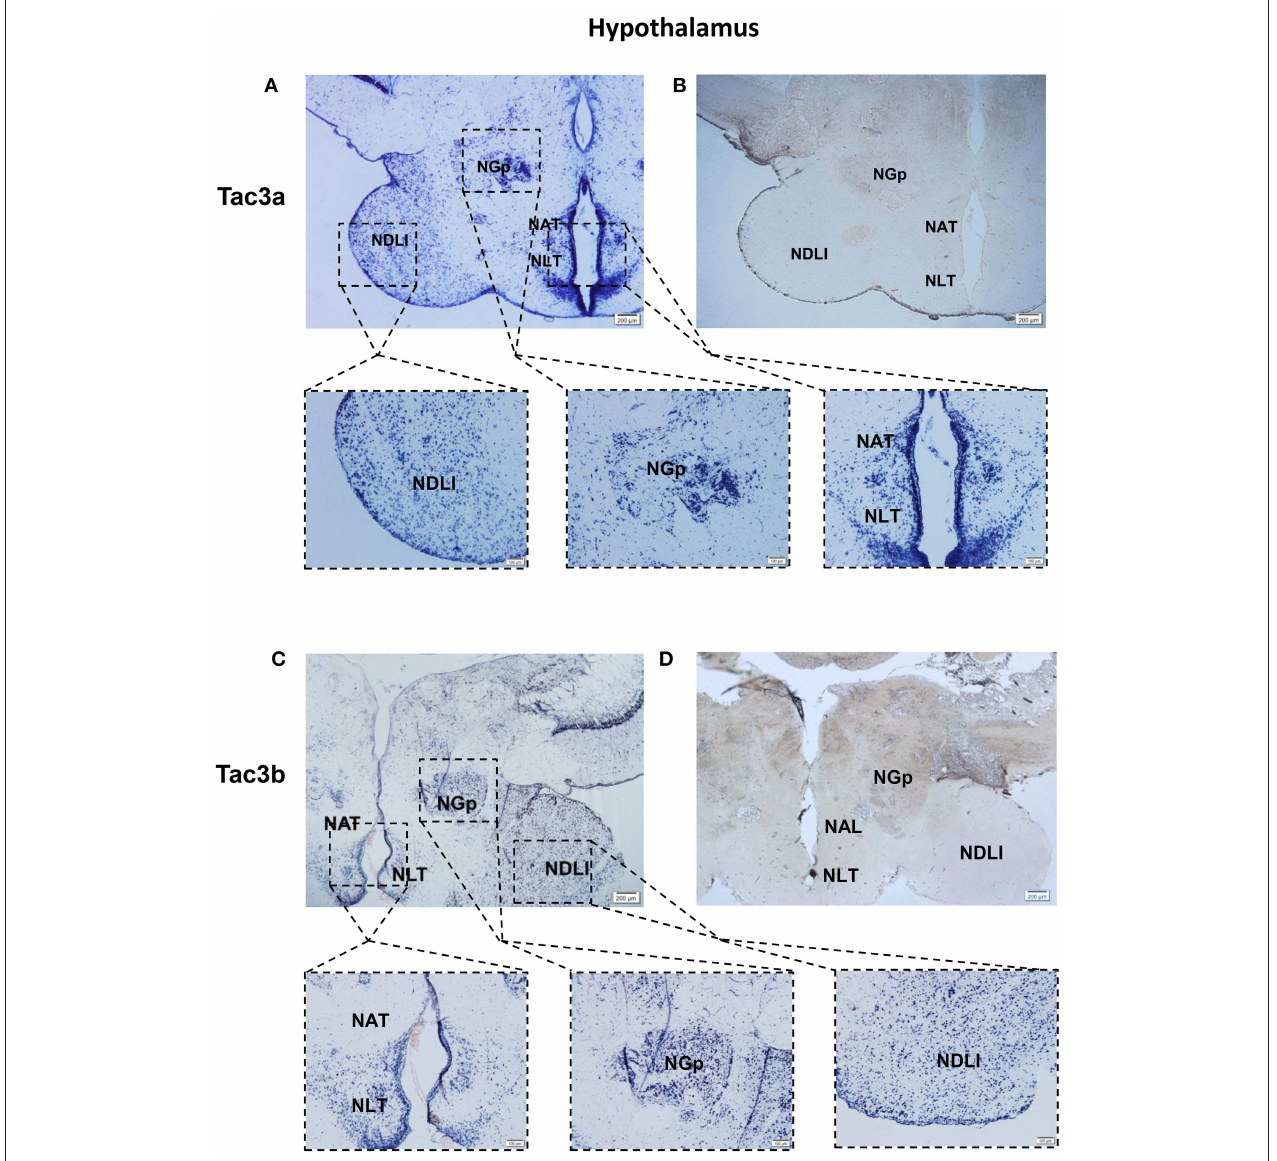
FIGURE 8 | Photomicrographs and schematic illustrations of the mRNA levels of tac3s in the hypothalamus of the spotted sea bass, as detected by in situ hybridization (ISH). Photomicrographs of tac3a and tac3b sense probe results in the hypothalamus (B,D) . Positive signal of tac3a and tac3b in the hypothalamus (A,C) . NDLl, diffuse nucleus of the inferior lobe; NLT, lateral tuberal nucleus; NAT, Nucleus anterior tuberis; NGp, posterior nucleus glomerulosus; TeO, tectum opticum; Val, lateral division of the valvula cerebella; Red and gray dots represent the locations of tac3a and tac3b , respectively.